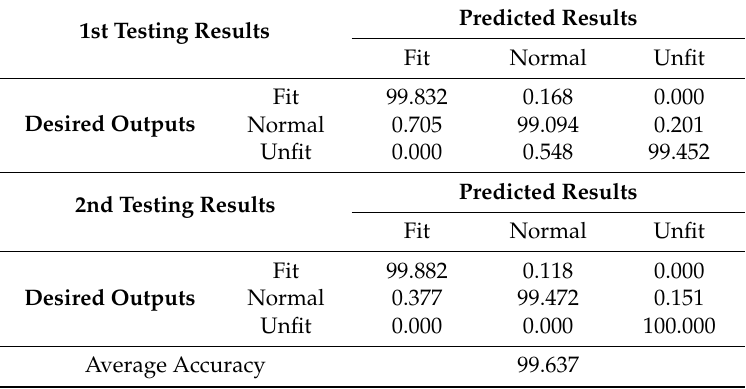
Table 6. Confusion matrices of the testing results on the USD banknote fitness dataset using the